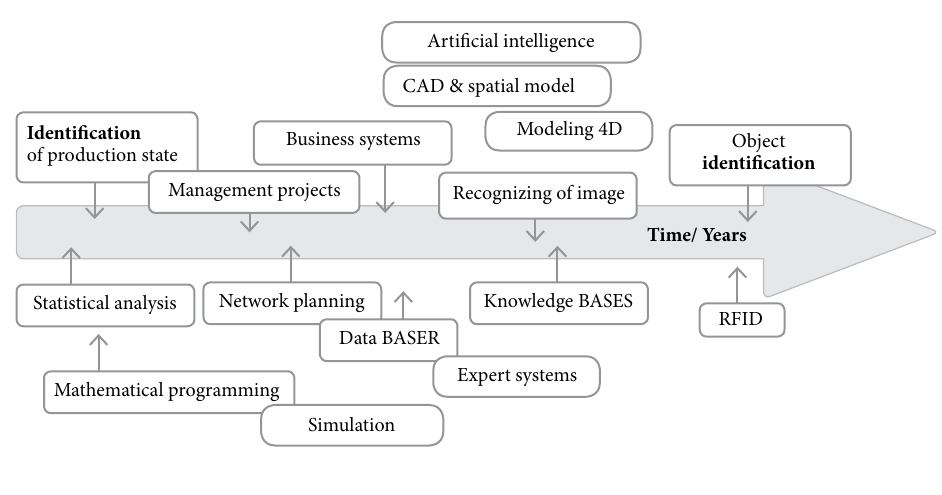
Fig. 3. Dynamic development of IT tools in construction project